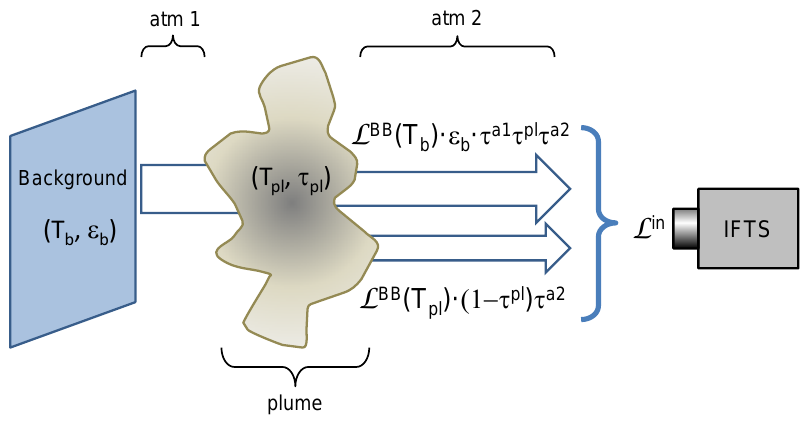
Figure 1. Schematics of the radiative